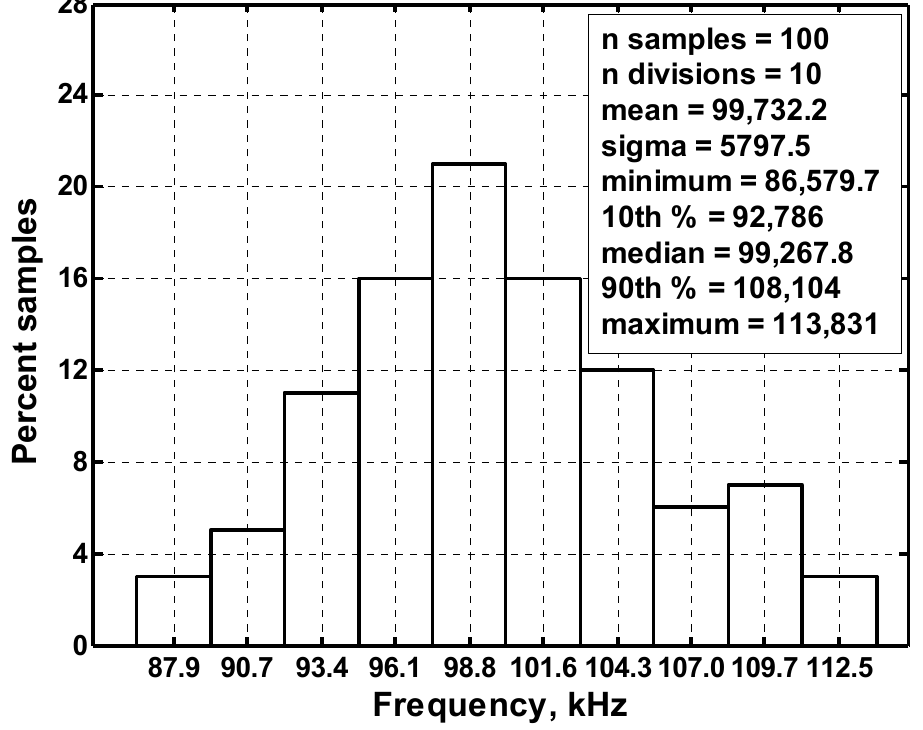
Figure 14. Histogram of the Monte-Carlo analysis.